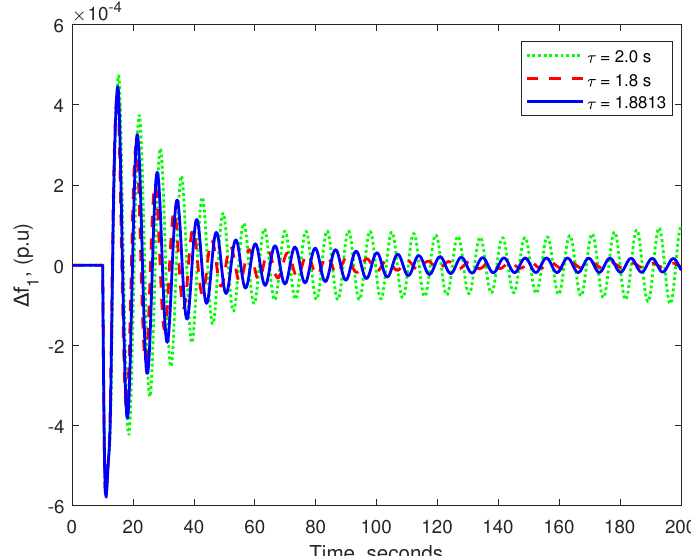
Figure 14. The frequency deviation in the first area.